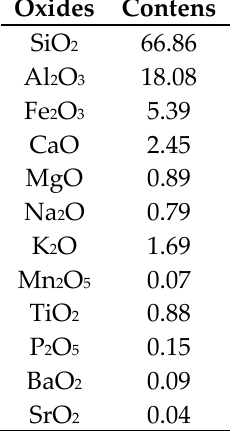
Table 1. Chemical composition of the standard